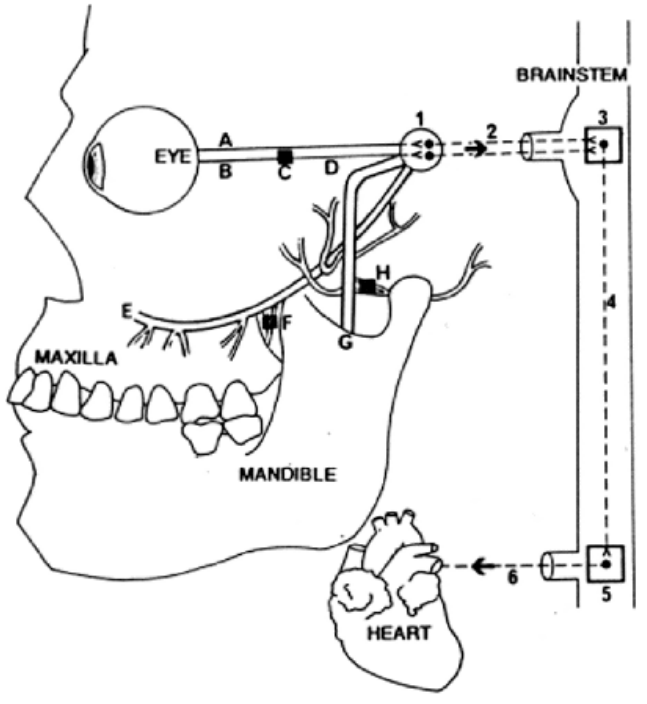
FIGURE 1. Drawing illustrating the pathway of the trigemino-cardiac reflex. (Adapted from Lang et al. [1991] Can. J. Anaesth . 38, 757–760 and Schaller et al. [1999] J. Neurosurg . 90, 215–220.) A = long ciliary nerve; B = short ciliary nerve; C = ciliary ganglion; D = ophthalmic nerve; E = maxillary nerve; F = pterygopalatine ganglion; G = mandibular nerve; H = otic ganglion; 1 = gasserian ganglion; 2 = trigeminal nerve; 3 = sensory nucleus of trigeminal nerve; 4 = short internucial fibers; 5 = motor nucleus of vagus nerve; 6 = vagus nerve.